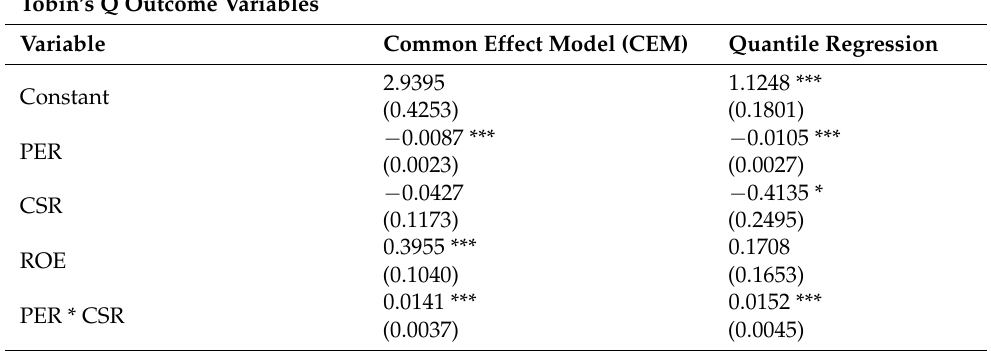
Table 5. Robustness